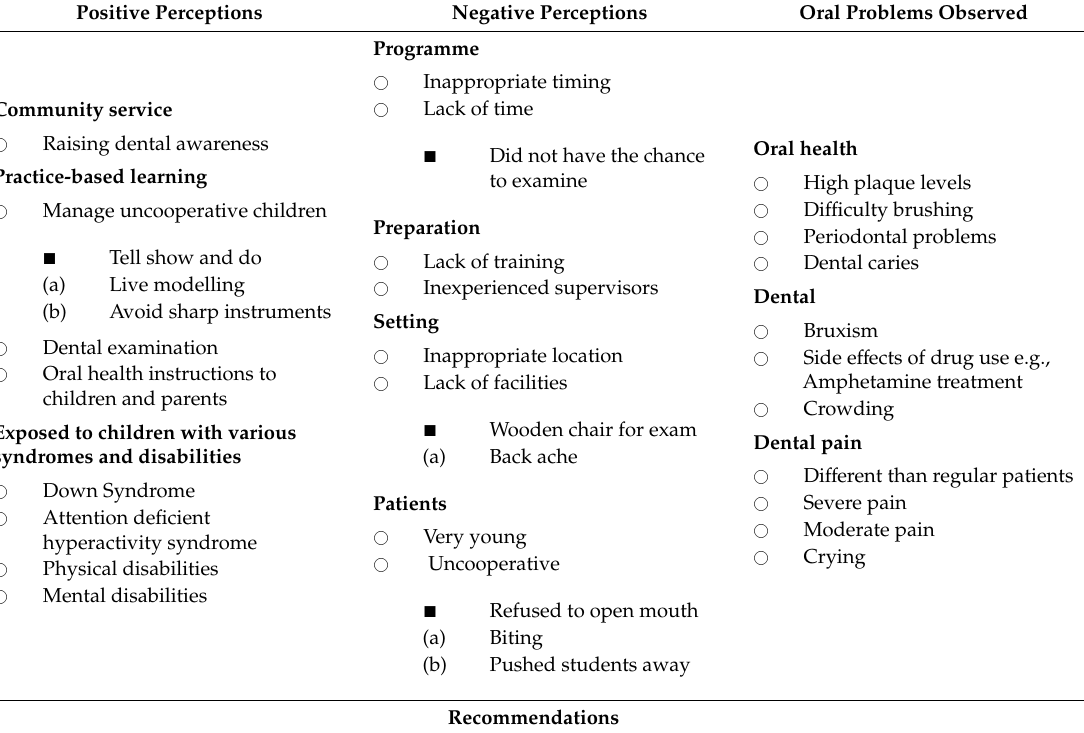
Table 4. Coding tree of student perceptions after the fieldwork visit showing the three main themes, their subthemes (bold) and elements (bullet